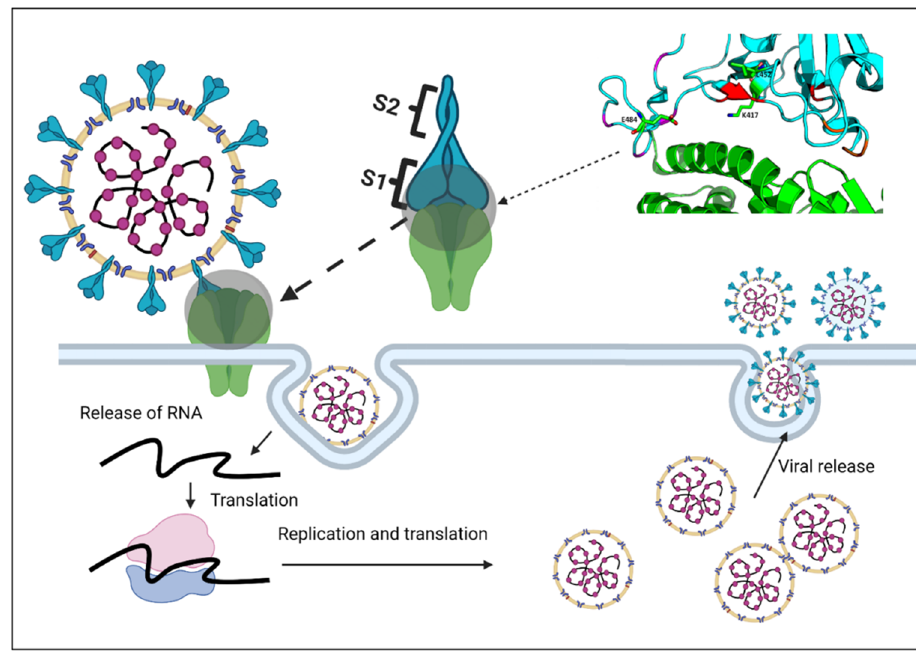
Figure 1. The viral entry mechanism of SARS-CoV-2 via the interaction of its spike protein with the host ACE2.